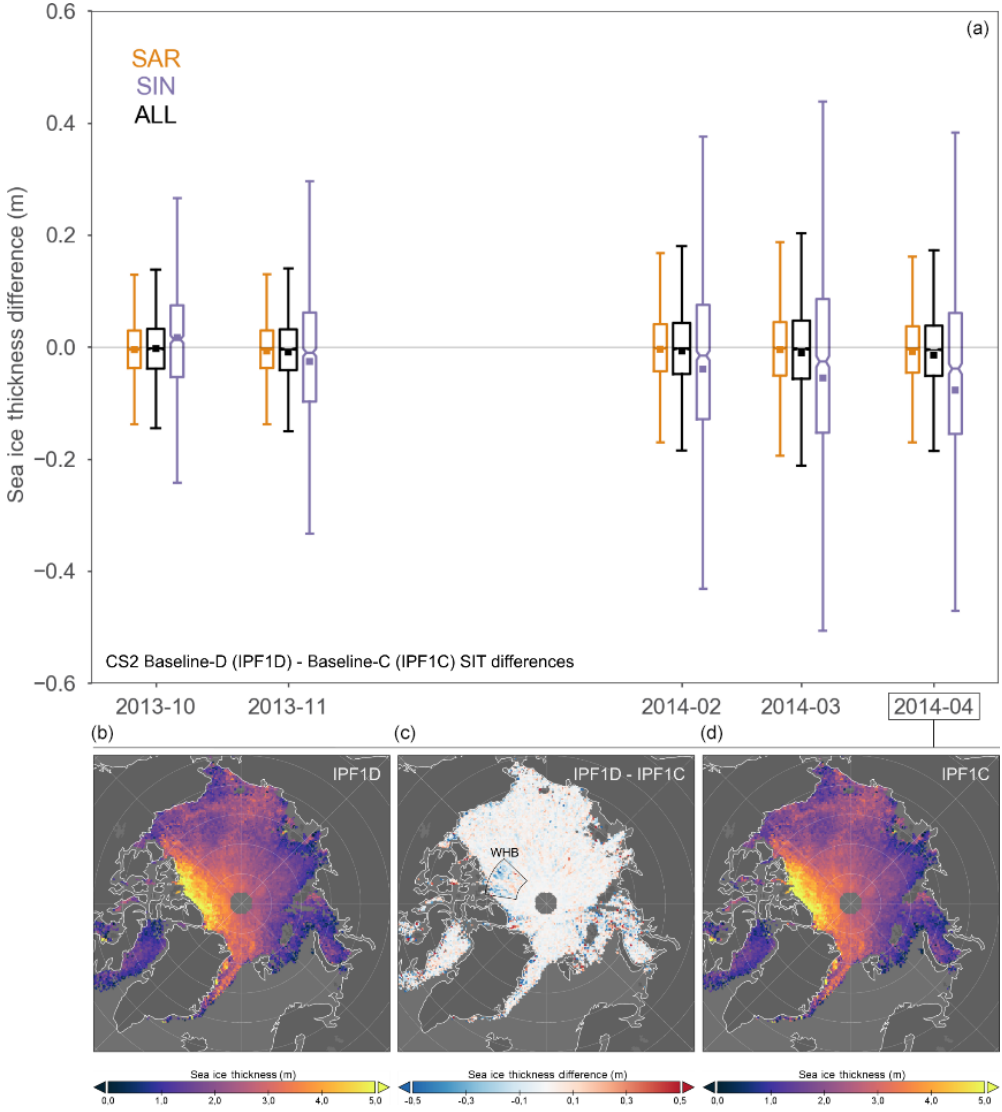
Figure 11. (a) Time series of gridded monthly sea ice thickness difference ( (cid:49) SIT) statistics for the AWI sea ice processing chain based on the Baseline-D test dataset and Baseline-C input. Differences (Baseline-D minus Baseline-C) are color coded for all 25km × 25km grid cells in the Northern Hemisphere (ALL) and separately for SAR and SIN input data. The inner box indicates the median difference with the confidence interval; the square marker indicates mean difference ( (cid:49) SIT) and the vertical line the maximum (cid:49) SIT range. (b–d) SIT maps in April 2014 for Baseline-D (b) , Baseline-C (d) and the Baseline-D–Baseline-C difference (c) . The marked region WHB (Wingham Box) indicates an area where CryoSat operated in SIN